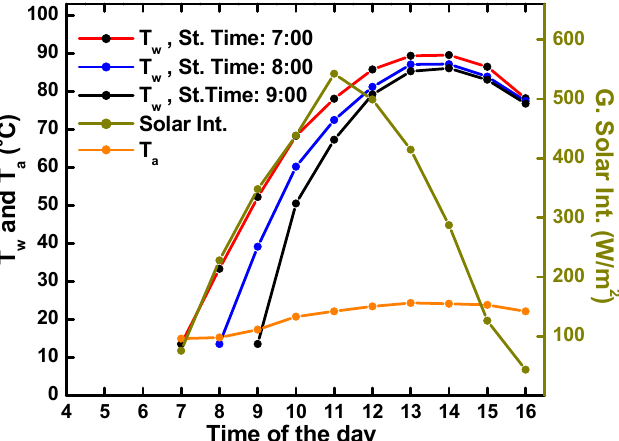
Figure 9. Water and ambient temperatures (T w and T a ) and global solar intensity as a function of the time of day, B. P. Al containers, different starting times, Sunny day, Date: 28 November 2021, Amman, Jordan.